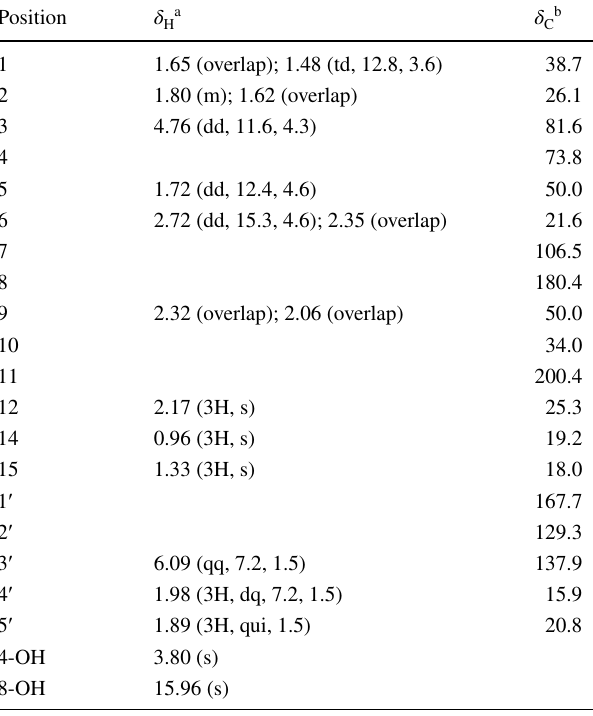
Table 1 NMR data of compound 1 ( δ in ppm, J in Hz)